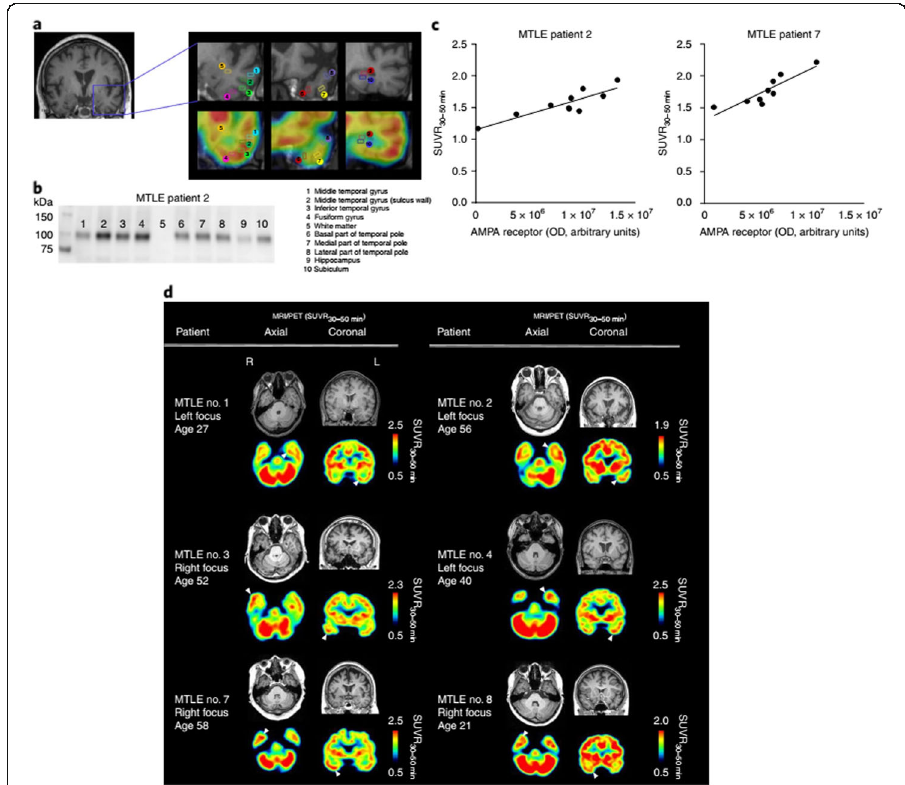
Fig. 3 PET imaging characteristics of [ 11 C]K-2 in patients with epilepsy. A: Presurgical MRI and PET images used to examine the correlation between AMPA receptor expression and retention of [ 11 C]K-2 in patient with MTLE. VOIs on individual MRI images were defined within the outline of expected resection areas (left). B: Representative immunoblot of resected brain tissues in a patient with MTLE performed with a pan-AMPA receptor antibody. The origins of the samples are listed on the right, corresponding to the numbers on the blot and VOI identifications. C: Correlations between SUVR 30-50min for [ 11 C]K-2 and the biochemical amount of AMPA receptor (OD) in multiple brain regions form patients with MTLE. D: SUVR 30-50min images of [ 11 C]K- 2 were obtained from 6 patients with MTLE. White arrows indicate the epileptogenic foci. This figure was obtained from Miyazaki et al. (2020) which was licensed under a Creative Commons License http://creativecommons.org/licenses/by/4.0/